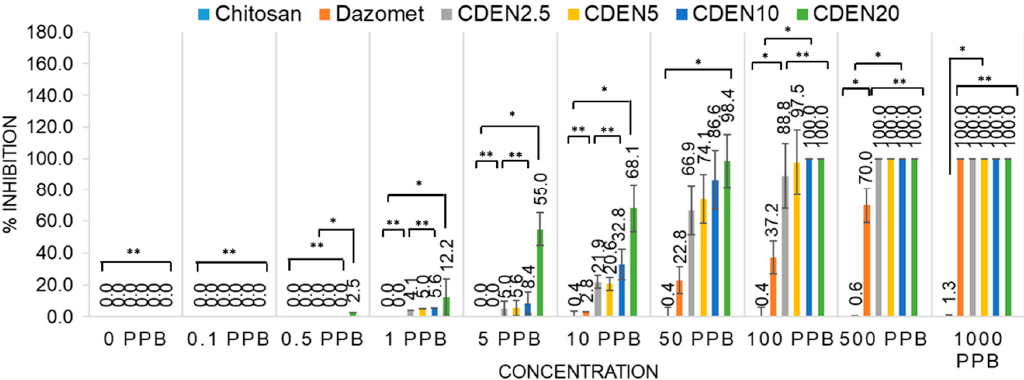
Figure 9. Percentage inhibition of radial growth on G. boninense against concentration at day 7 of incubation at 28 ± 2 °C of chitosan, pure dazomet, and chitosan-dazomet nanoparticles at various concentrations of TPP, where * p < 0.01 (significant) and ** p > 0.5 (not significant); the error bars represent standard deviation of the mean. Table 2. Calculated half maximum effective concentration (EC 50 ) of chitosan, pure dazomet, and chitosan- 28 ± 2 °C.